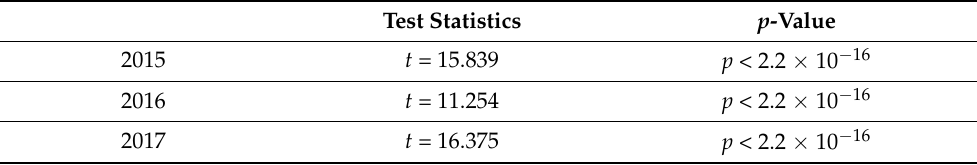
Table 5. The t -test Results.